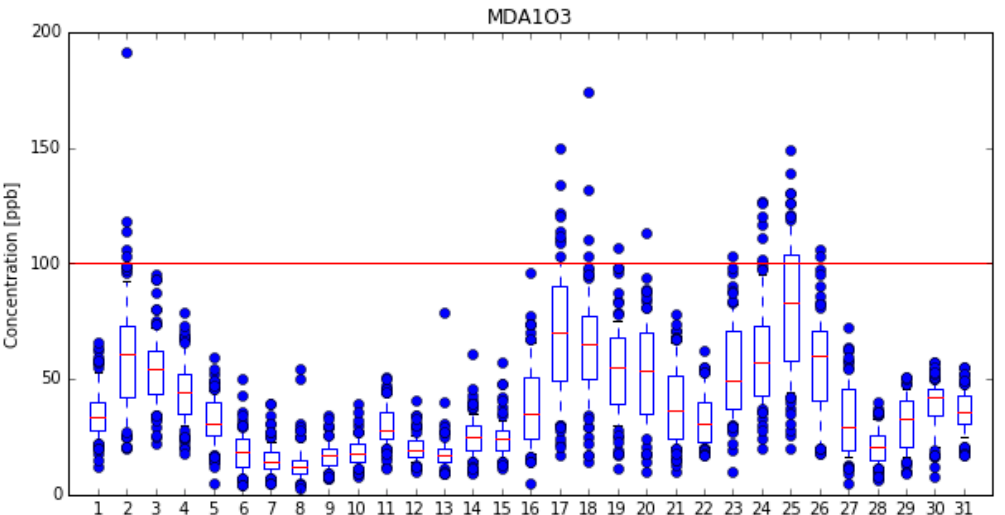
Figure 2. Box and whisker plot of MDA1O3 values at all monitors in the 3-km modeling domain during August 2007. Blue dots are MDA1O3 values outside the 10–90 percentile range for each day in August 2007. The red line indicates the one-hour Ozone Air Quality Standards (O3AQS) level.